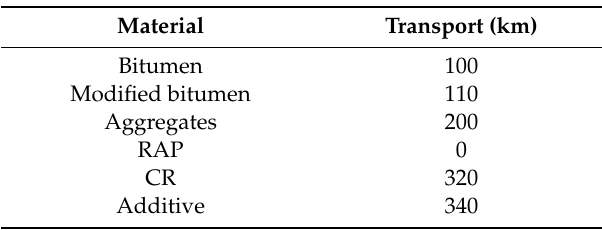
Table 7. Travelling